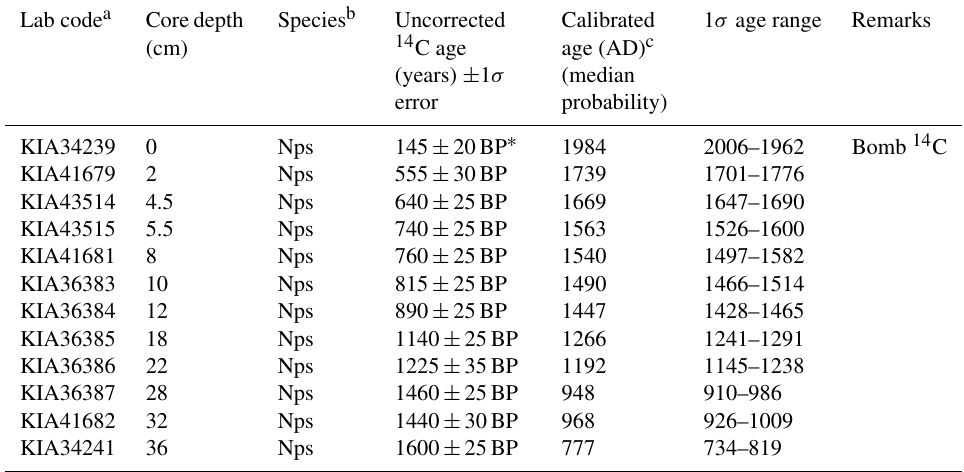
Table 1. Site GS06-144-03 MC-A chronology, based on 12 accelerator mass spectrometry (AMS) 14 C dates performed on the calcareous shells of the planktonic foraminifera Neogloboquadrina pachyderma